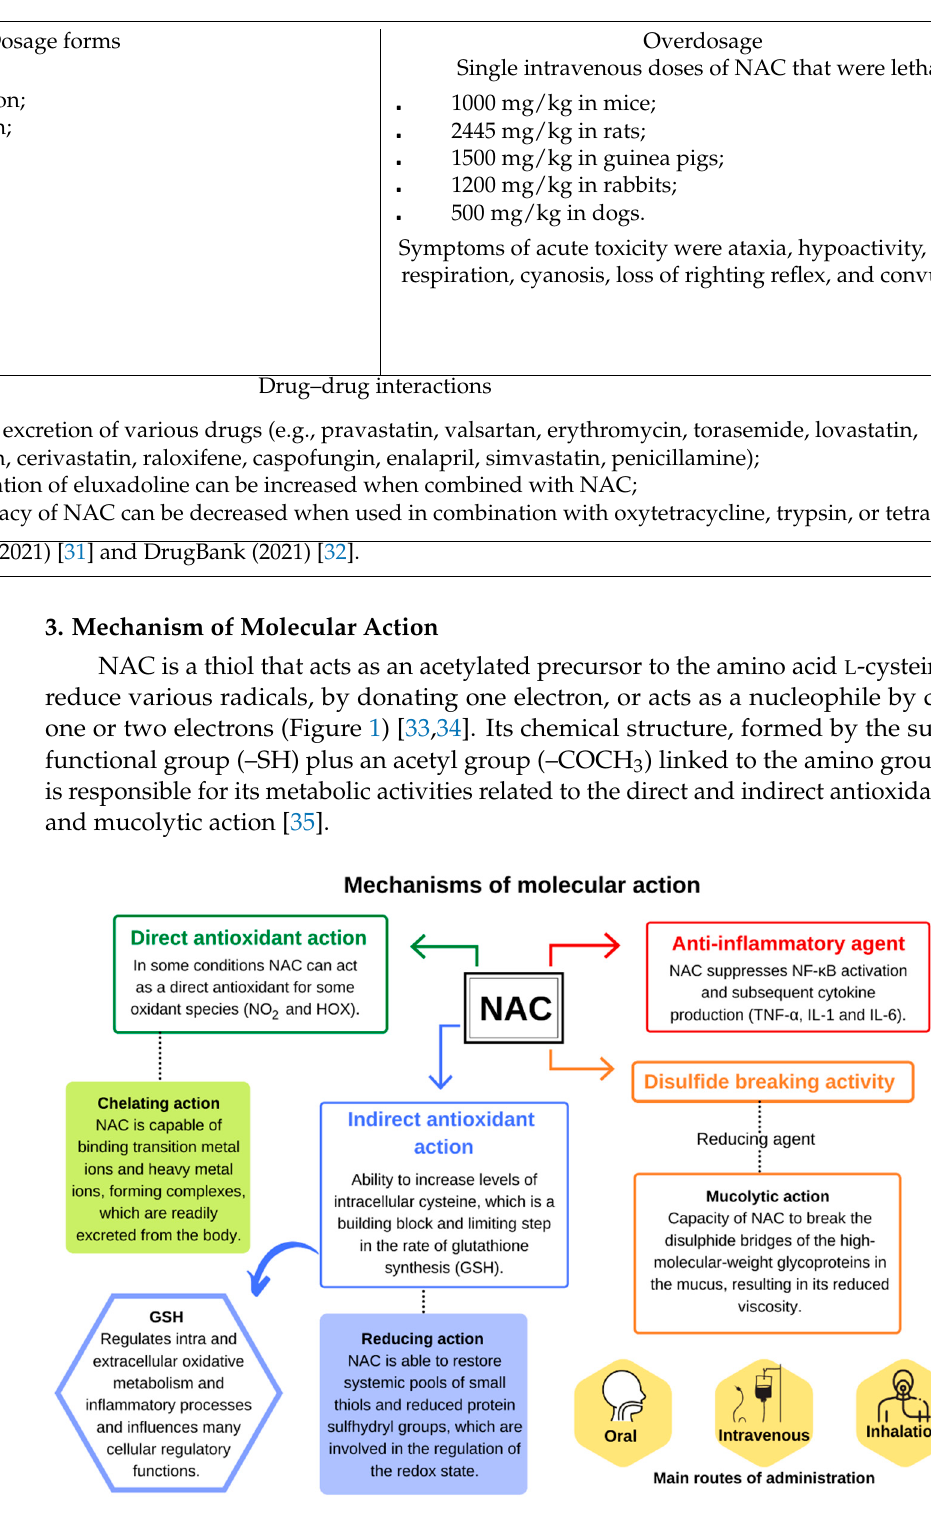
Figure 1. Mechanism of molecular action of N -acetylcysteine. Adapted from Aldini et al. (2018) [3]. The direct antioxidant activity of NAC is due to the ability of its free thiol group to react with reactive oxygen and nitrogen species (RONS) [36]. Under